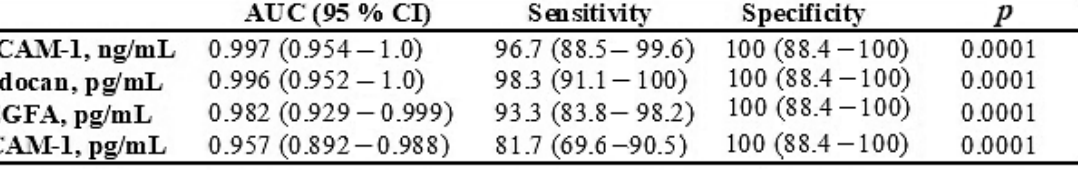
Figure 3. Receiver operating characteristic curve analysis of sVCAM-1 (a), endocan (b), VEGFA (c), and sICAM-1 (d).